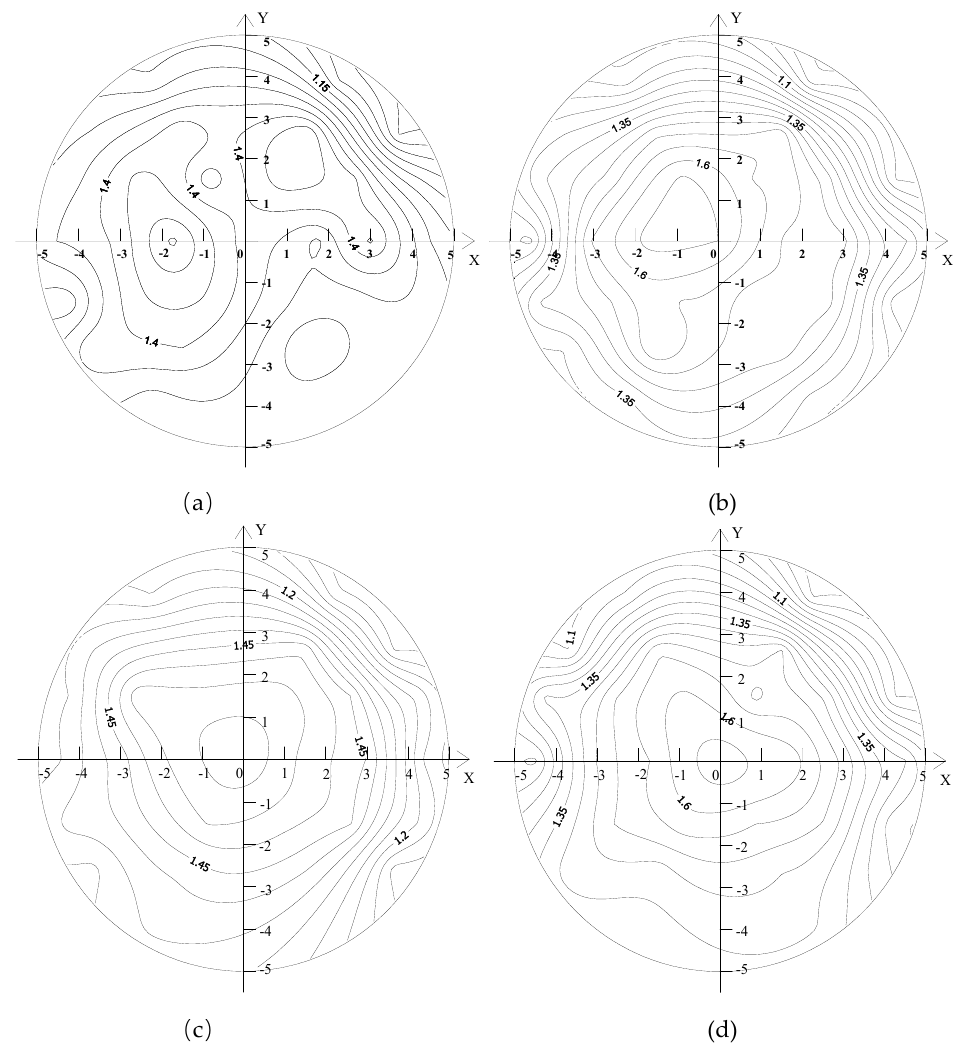
Figure 8. Axial velocity distributions of the downstream sections of capsules: ( a ) L / d = 2.5, Z = 0.2m; ( b ) L / d = 2.14, Z = 0.2m; ( c ) L / d = 2.5, Z = 3m; and ( d ) L / d = 2.14, Z = 3m.